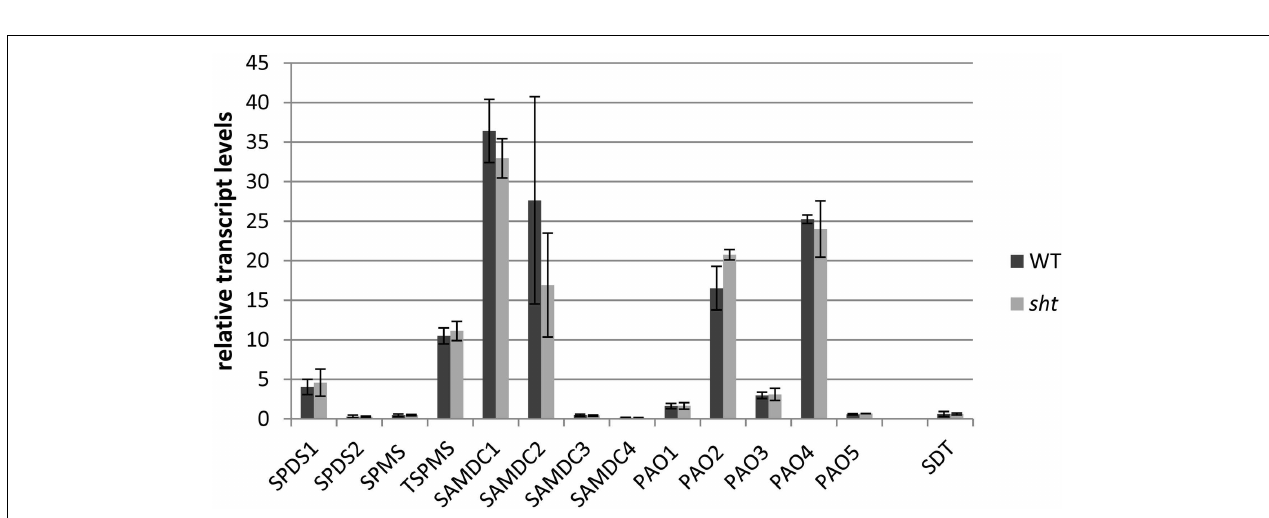
FIGURE 6 | Ratio of free and bound spermidine in A. thaliana wild type stamen (A) and amounts of all three PAs in stamen of wild type and sht stamens (B) and pollen grains (C). (A) The quantity of the single most prominent HCAA N 1 , N 10 -bis-(5-hydroxyferuloyl)- N 5 -sinapoyl-spermidine was